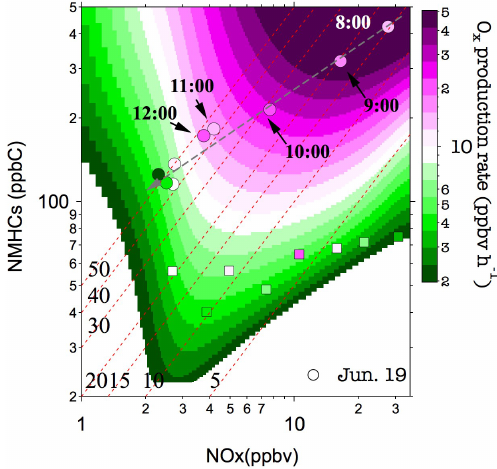
Figure 7. O 3 production isopleth plot derived from RACM sen- sitivity simulations at the observation site. The gray dashed line indicates the diurnal variation of the ambient NO x concentra- tion on 19 June 2010. The red dotted lines represent the ratio of NMHC / NO x